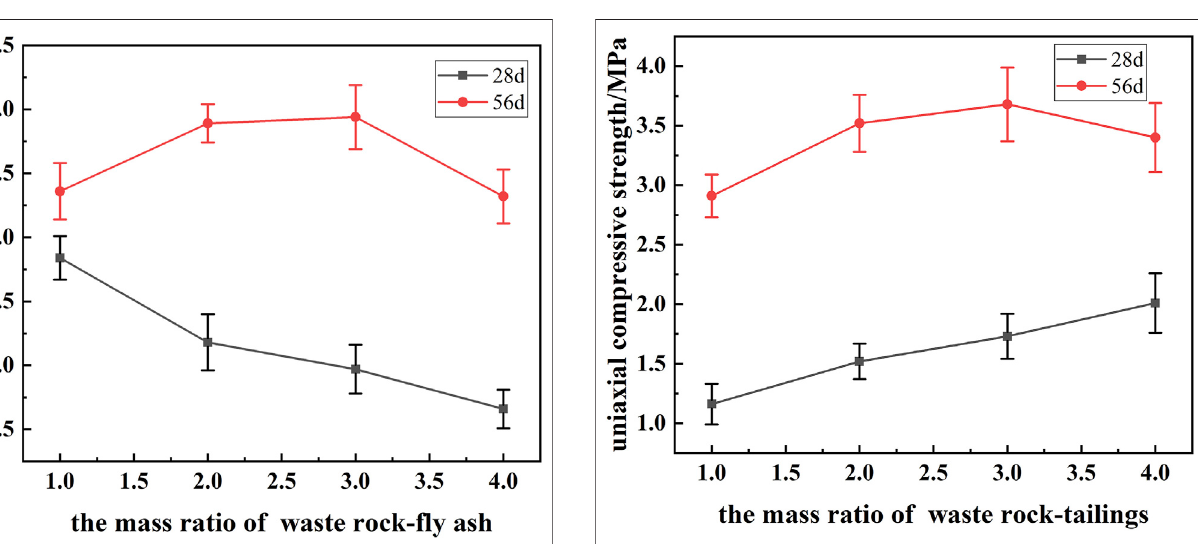
FIGURE 9 | The relationship between back fi ll strength and mass ratio of waste rock to fl y ash (group C).